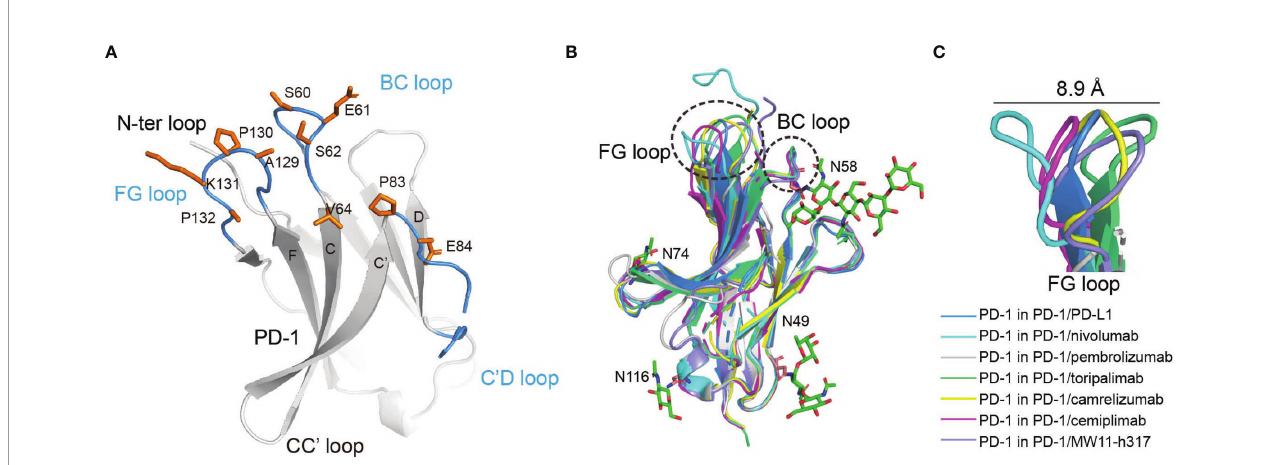
FIGURE 2 | The structure characterization of PD-1 upon binding to MAbs. (A) The key region of PD-1 binding to cemiplimab. The b -strands of PD-1 are represented as the capital characters C, C ′ , D, F, and G, respectively. The CC ′ , C ′ D, and FG loops of PD-1 are highlighted in the blue cartoon, and the key epitopes of PD-1 binding to cemiplimab are shown as orange sticks, respectively. (B) Superposition of PD-1 upon binding to the PD-L1 ligand or different MAbs, including the PD-1 extracted from the complex structures of PD-1/PD-L1 (blue) (PDB code: 4ZQK), PD-1/nivolumab (cyan) (PDB code: 5WT9), PD-1/pembrolizumab (gray) (PDB code: 5JXE), PD-1/ toripalimab (green) (PDB code: 6JBT), PD-1/camrelizumab (yellow) (PDB code: 7CU5), PD-1/cemiplimab (magenta) and PD-1/MW11-h317 (light blue) (PDB code: 6JJP). FG loop and BC loop of PD-1 which contributed vital binding to the cemiplimab are shown as a dashed line in black. (C) Flexible conformations of the FG loop of PD-1 upon binding to PD-L1 or different